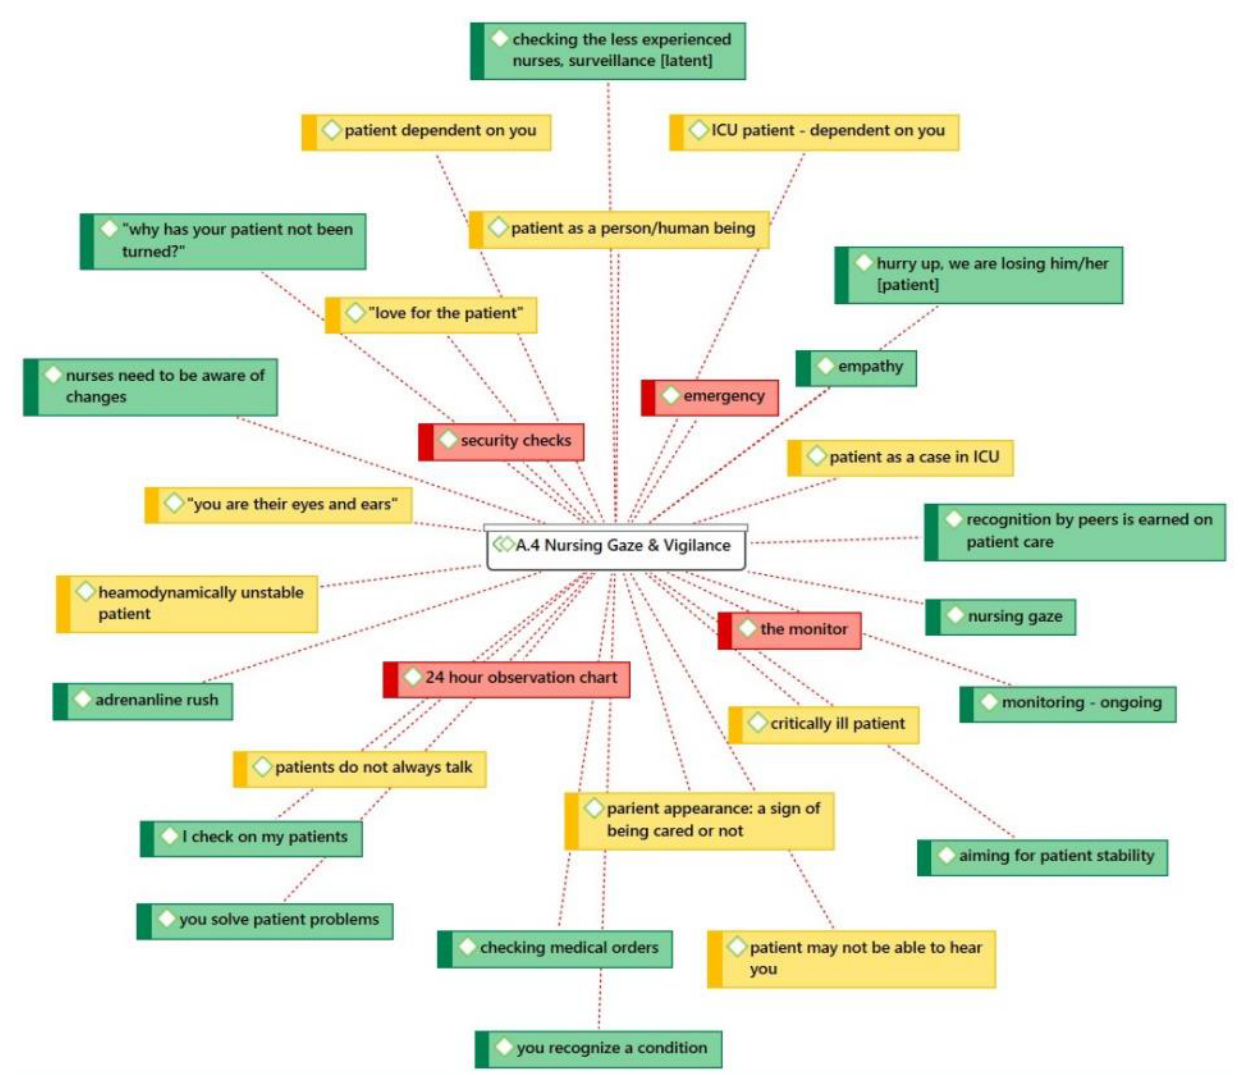
Figure 1. Nursing gaze and vigilance. ICU nurse Akrivi is “co-present” and “proximal”, to her patient, both metaphorically and literally. She constantly has her patient in her mind, “she cares for him”, and does what is necessary to keep him alive. Her vigilant eye makes sure that all their bodily functions are monitored and recorded, and that no major functions, such as airway patency, breathing, and blood pressure, are failing the patient. At the same time, she feels the patient’s pain and suffering, she speaks to him, supports him, touches him gently with her hands, and reassures him. The participants expressed empathy for their patients’ needs and problems, especially when verbal communication with the patient was not possible, due to the threatening critical illness or